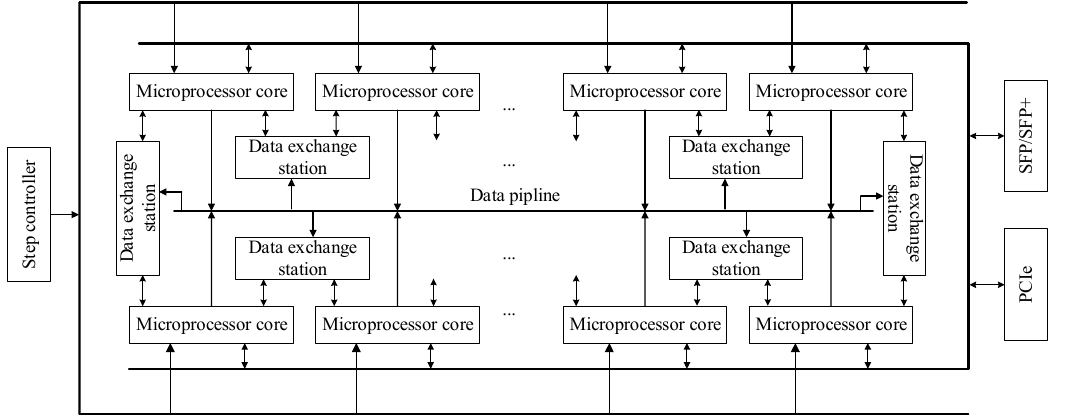
Figure 2. The overall structure of real-time digital solver based on FPGA (FRTDS).